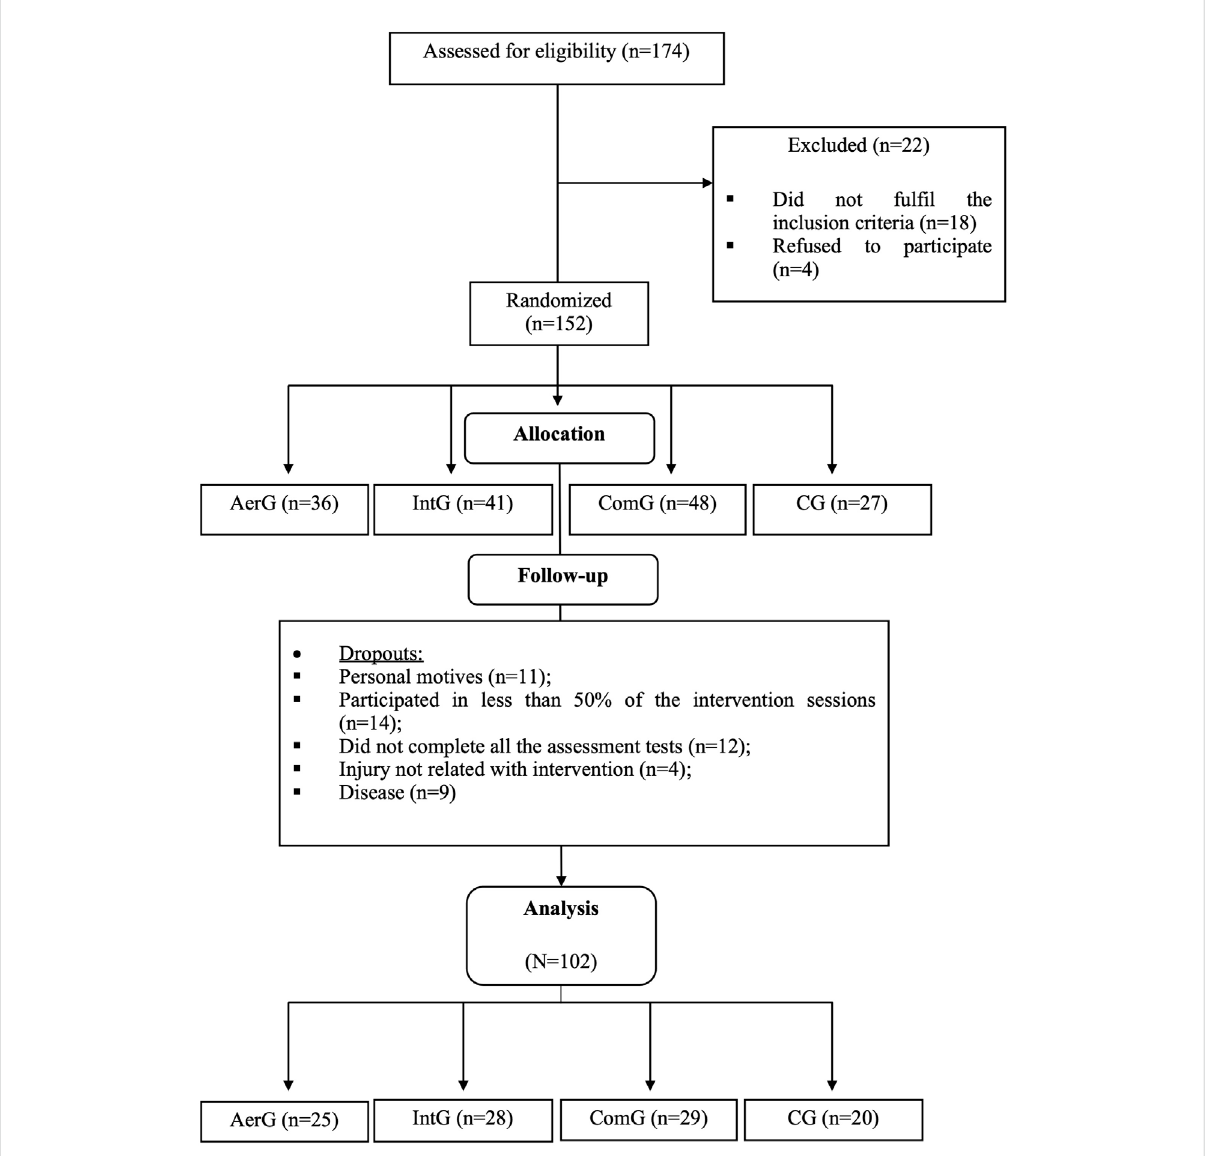
FIGURE 1 Allocation process for the different groups:Continuous aerobic group (AerG); Aerobic interval group (IntG); Combined group (ComG); Control group